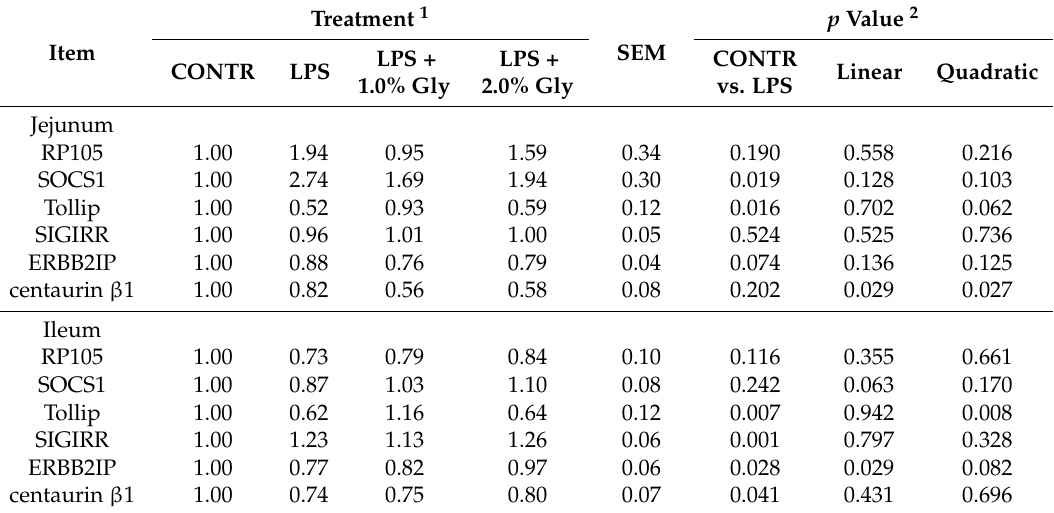
Table 6. Effects of glycine supplementation on intestinal mRNA expression of negative regulators of TLR4 and NOD signal pathway after 4 h LPS challenge in